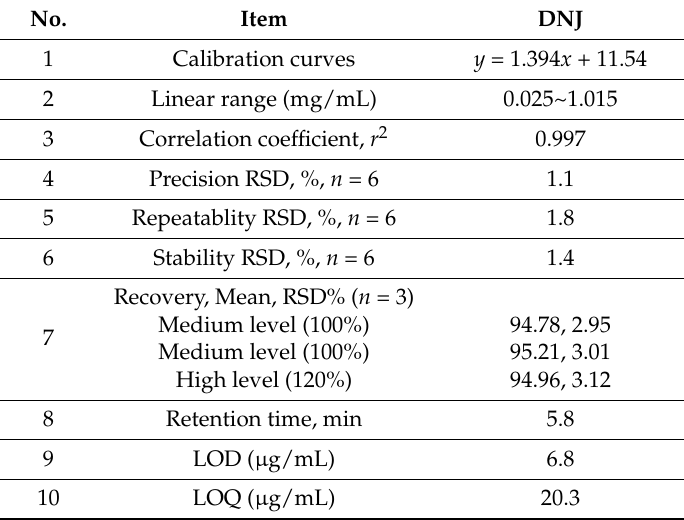
Table 2. Characteristics of chromatographic peaks of DNJ in method validation.